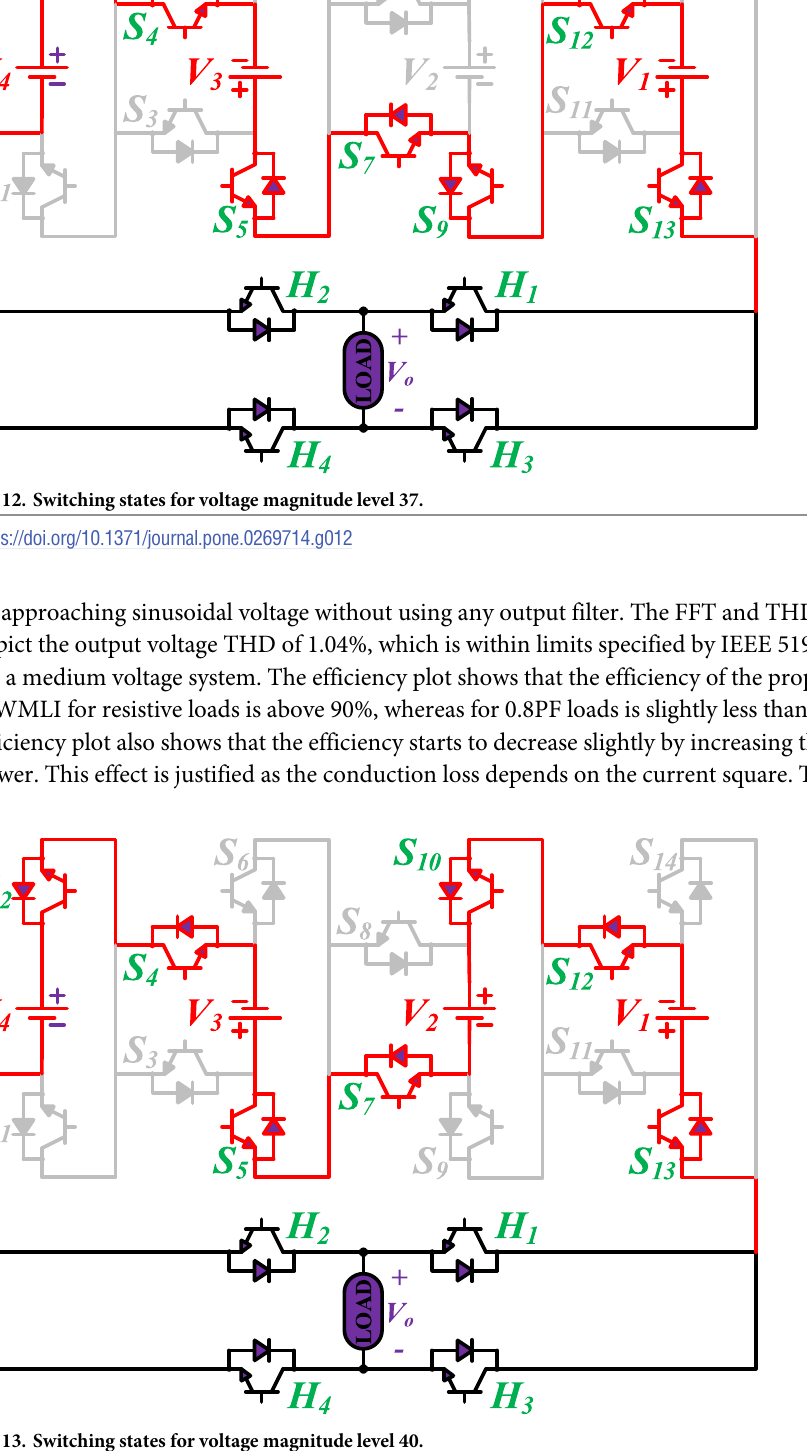
Fig 13. Switching states for voltage magnitude level